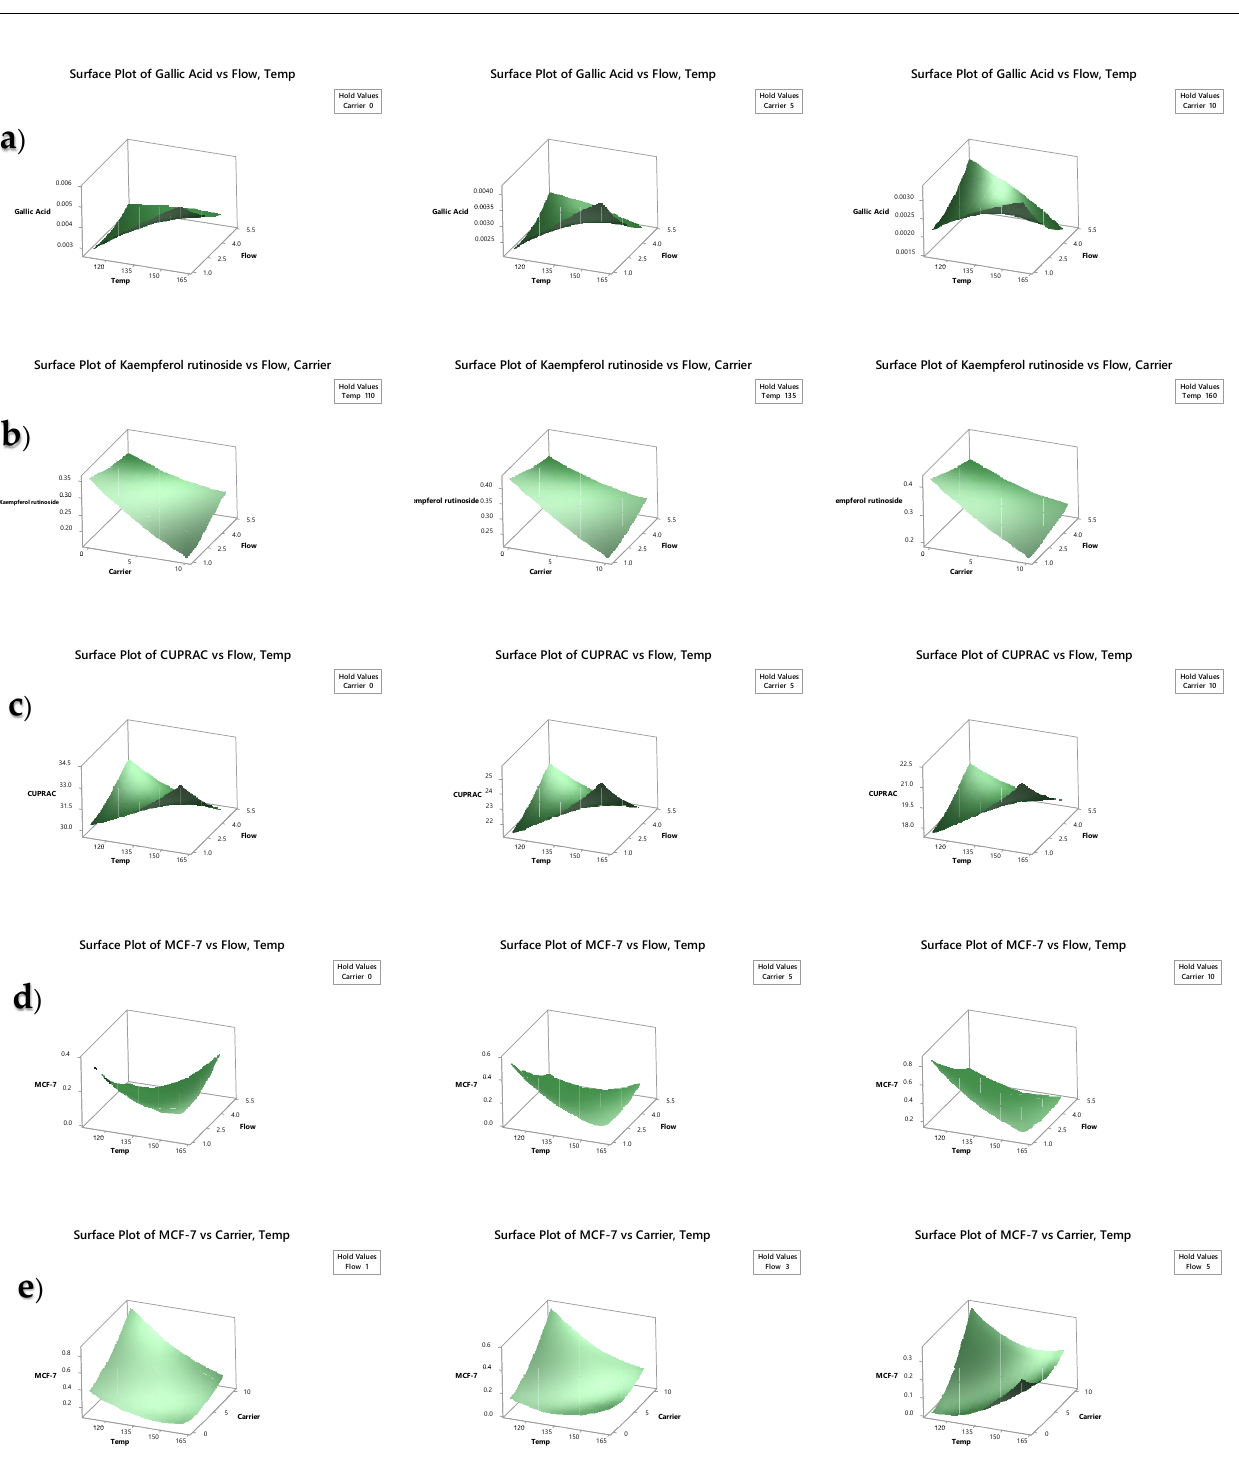
The high antioxidant capacity of tamarillo makes it a good source of natural dietary supplement [1,2]. The effect of spray-drying processing parameters on the antioxidant activities (CUPRAC, FRAP, and PM), as well as the total phenolic (F-C), total flavonoid (TF) and total carotenoid content (TCC) of tamarillo powder, were evaluated. The